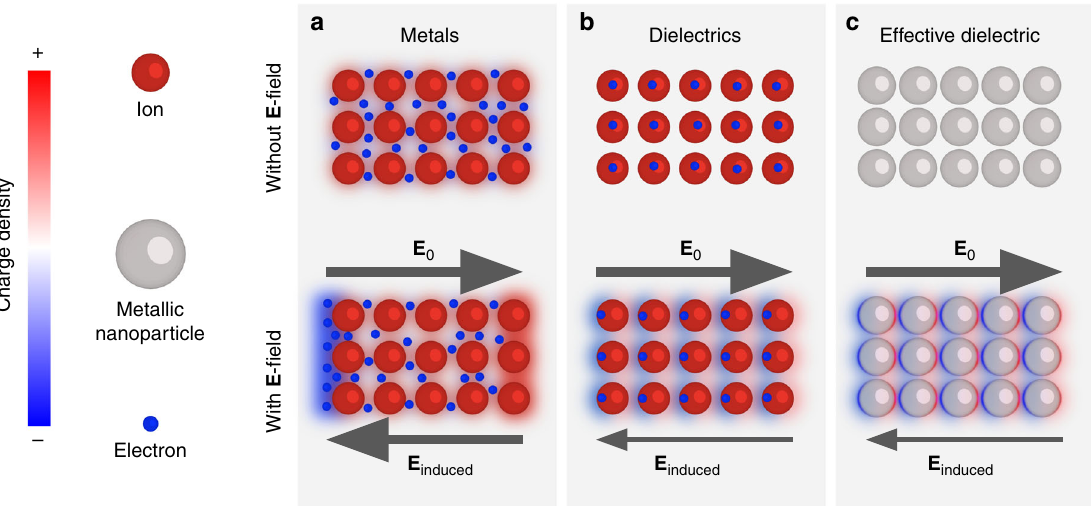
Fig. 1 An illustration of how metals, dielectrics, and effective dielectrics respond to a slowly varying electric fi eld. Within in each system, the applied fi eld is opposed by an induced electric fi eld generated by the build up of surface charges. a In metals, the electrons are free to move until the applied and induced fi elds cancel in the bulk. In dielectrics ( b ) and effective dielectrics ( c ), the surface charge is generated by the polarisation of the (meta-)atoms or (meta-) molecules, and the induced fi eld is weaker than the applied fi